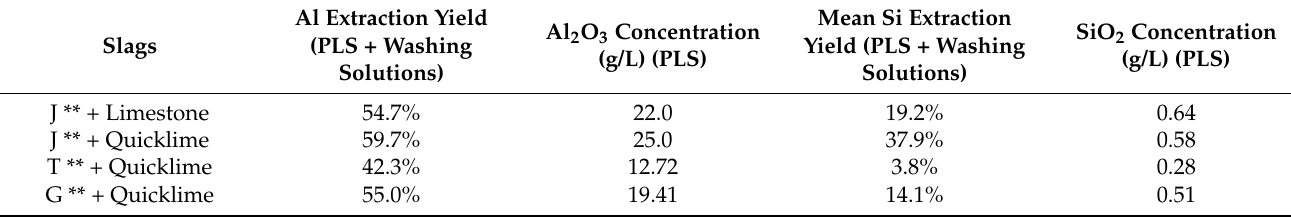
Table 2. Results of standard leaching tests performed on slags.